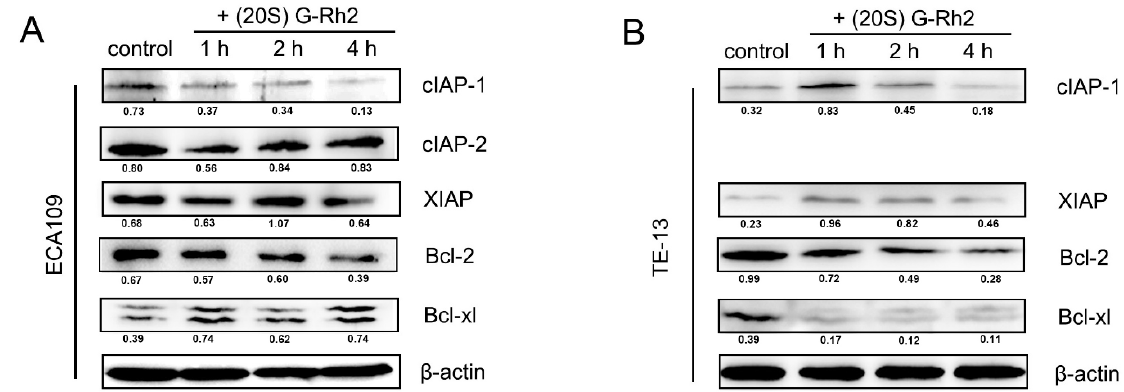
Figure 5. The expression level of apoptosis-regulated proteins in ECA109 ( A ) and TE-13 ( B ) cells after being treated with (20S) G-Rh2.